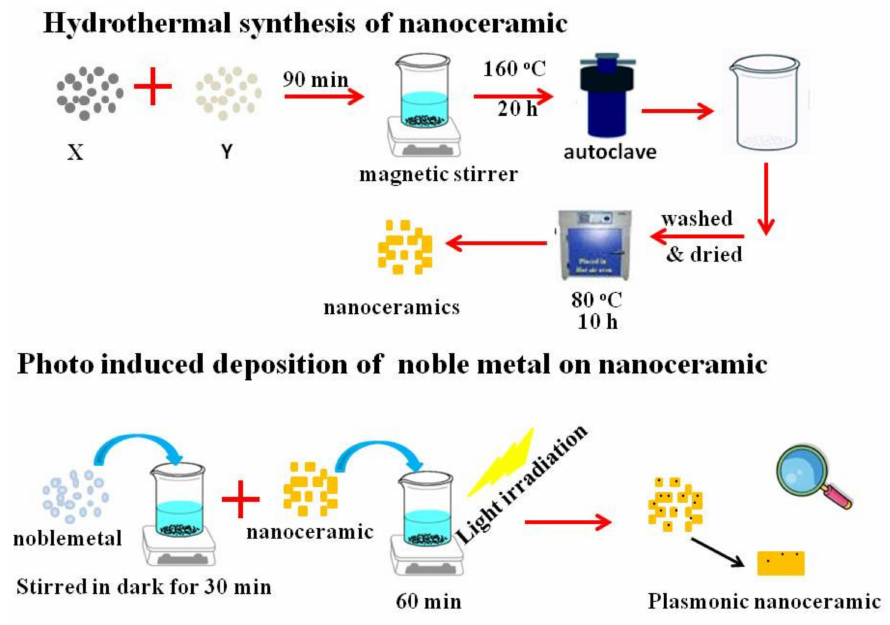
Figure 2. Schematic representation of the synthesis of Ag/Bi 2 WO 6